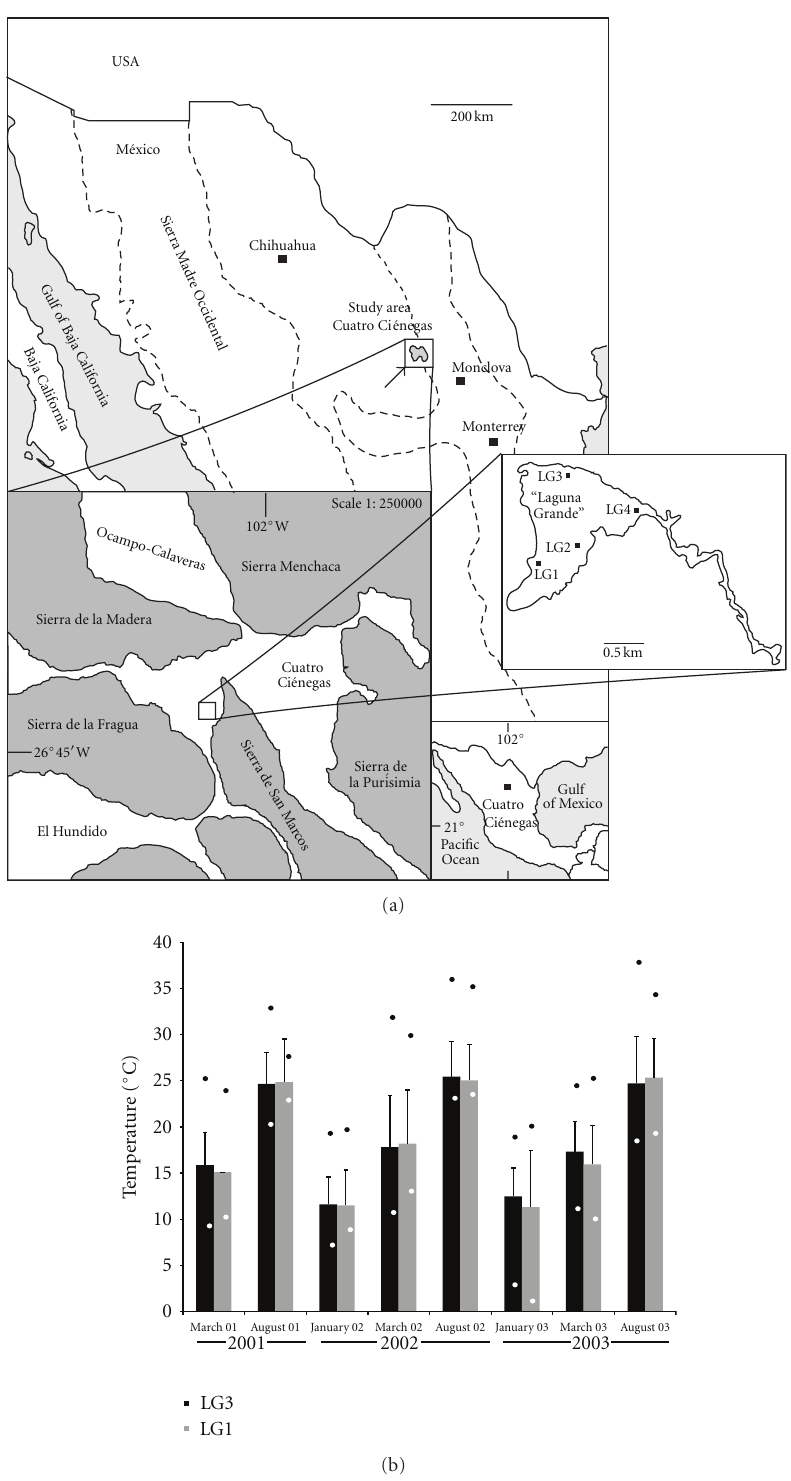
Figure 1: Study site in the Cuatro Cienegas basin. (a) Geographic location of the study site, indicating the sampling sited within “Laguna Grande” (desiccation lagoon) of the Churince system (modified from [8, 11]). (b) Average water temperature in two sites (LG1 and LG3) of “Laguna Grande.” Temperature was measured hourly over two weeks; average temperatures are significantly higher during summer than winter [17]. Error bars represent standard deviations, white dots and dark dots represent minimum and maximum temperatures, respectively